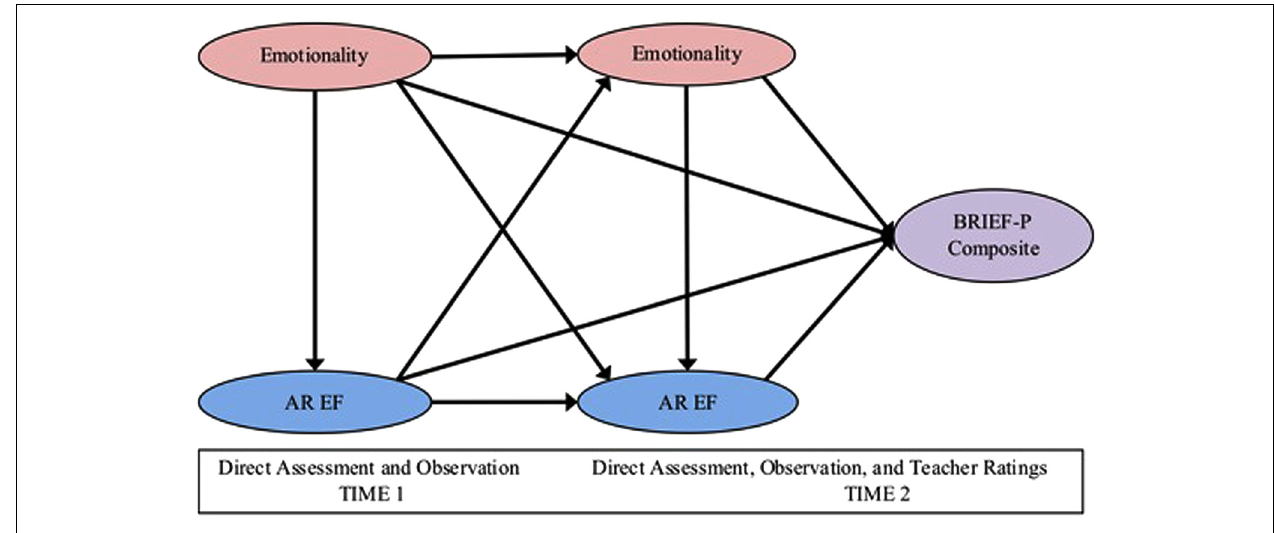
FIGURE 1 | Partial least-squares outer model.